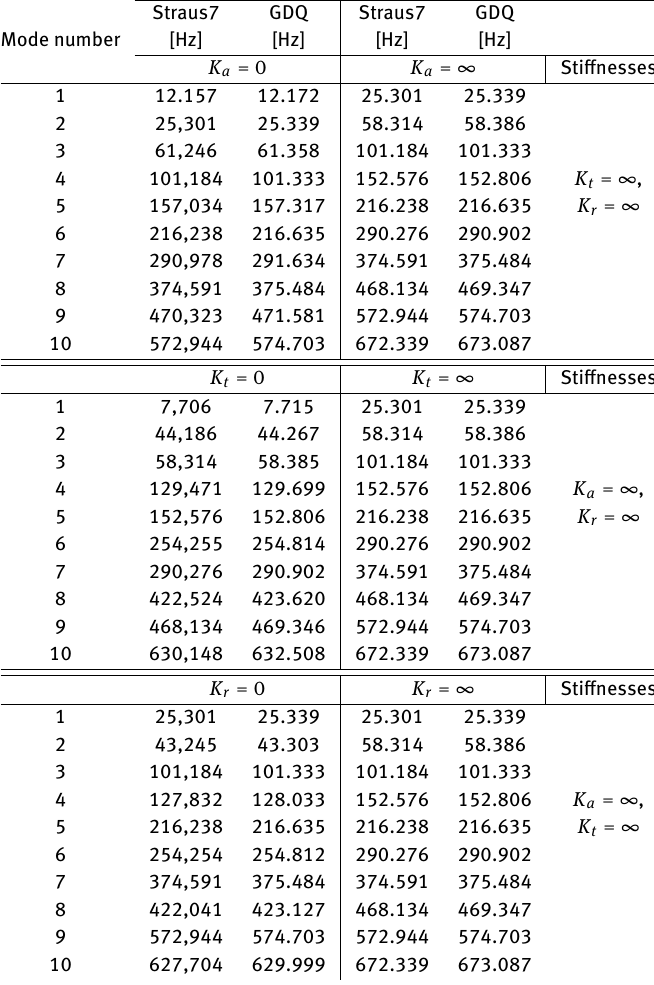
Table 6: First ten natural frequencies for the limiting values of the spring stiffnesses ( K a = 0, ∞ ; K t = 0, ∞ and K r = 0, ∞ ): Straus7 - GDQ